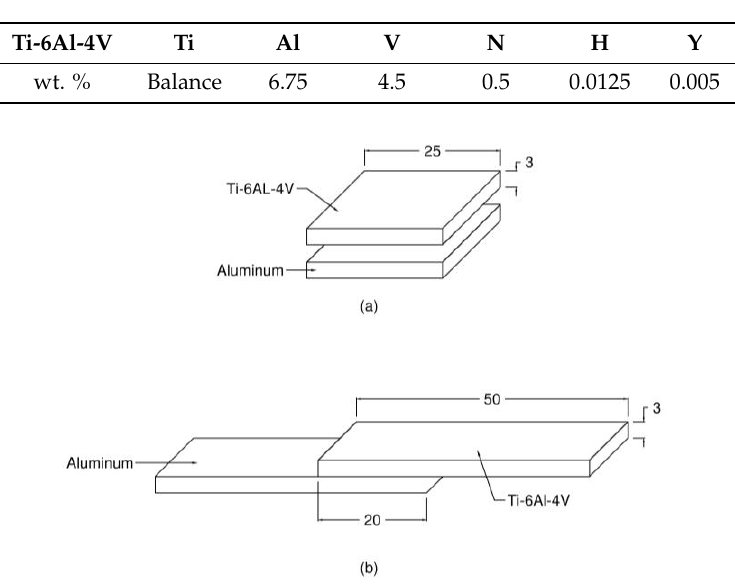
Table 2. Ti-6Al-4V chemical composition.